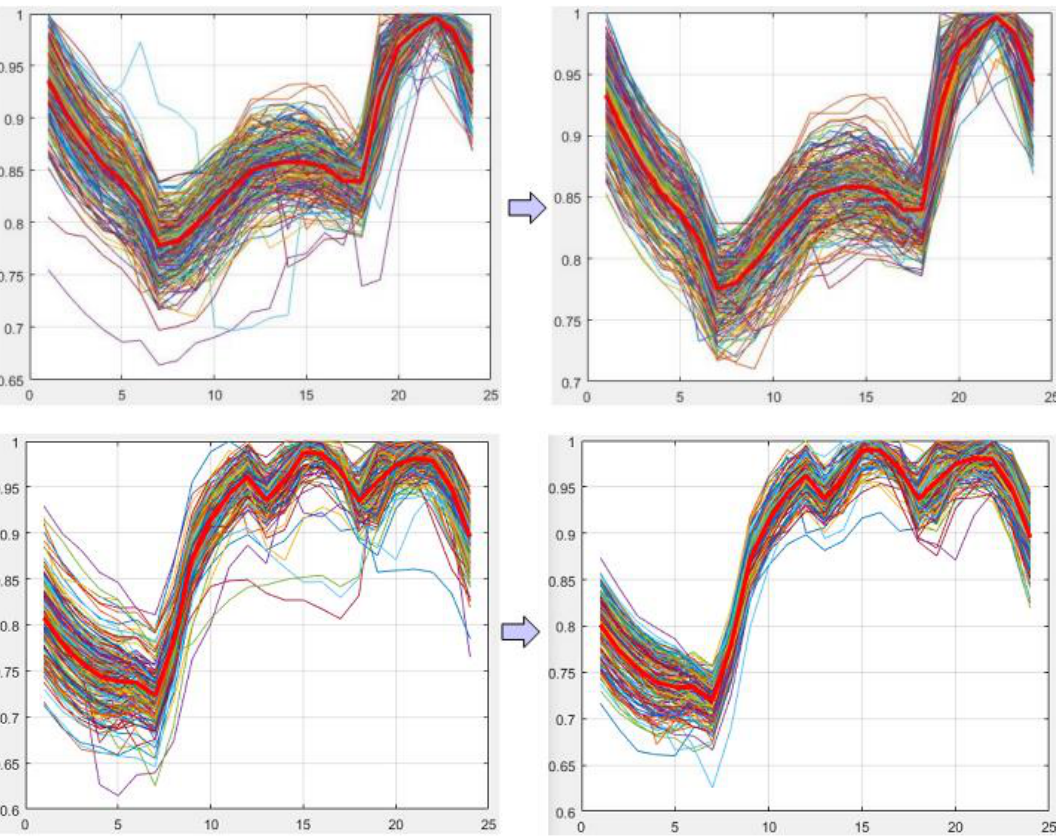
Figure 13. Identification of typical curves for the Sunday ( top row ) and Monday ( bottom row ) for Market 1.